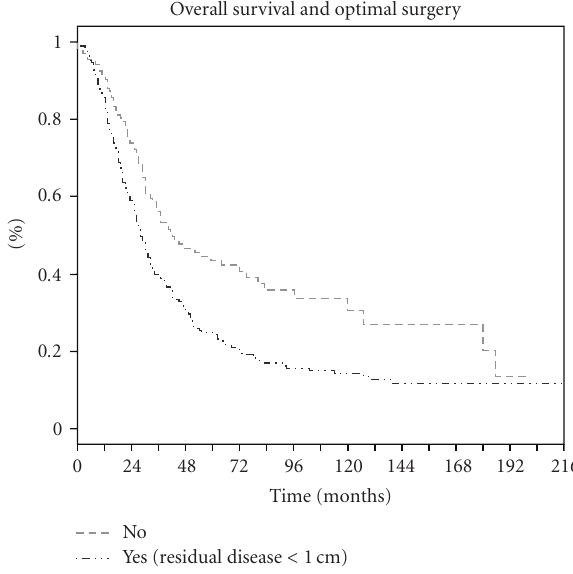
Figure 1: Overall survival and optimal